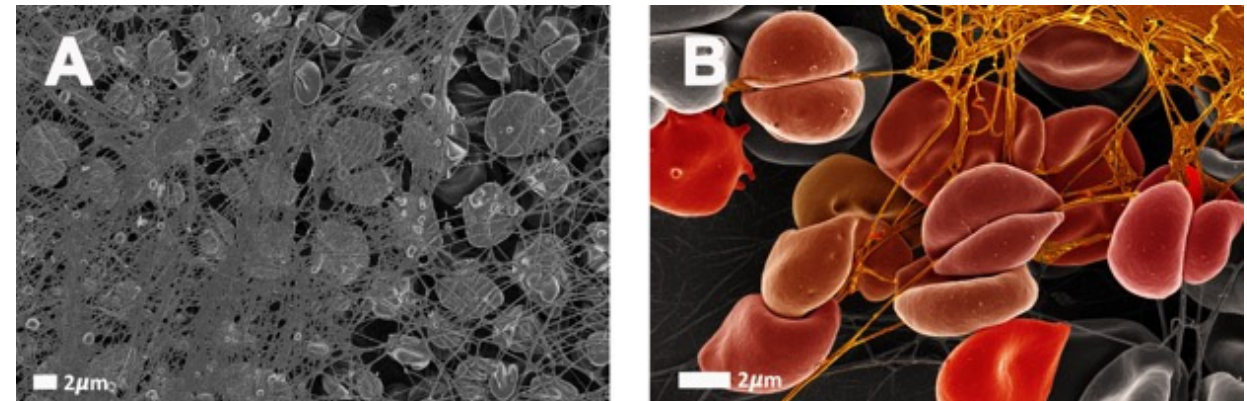
Figure 2. Morphology of RBCs in the presence of high circulating serum ferritin. This picture shows that in conditions like hemochromatosis, RBC structure is markedly compromised. ( A ) Individual with hereditary hemochromatosis (H63D/C2882Y), serum ferritin level 374 ng/mL − 1 ; ( B ) individual with hereditary hemochromatosis (H63D/wild type), serum ferritin level 1500 ng/mL − 1 . Raw data from [72].